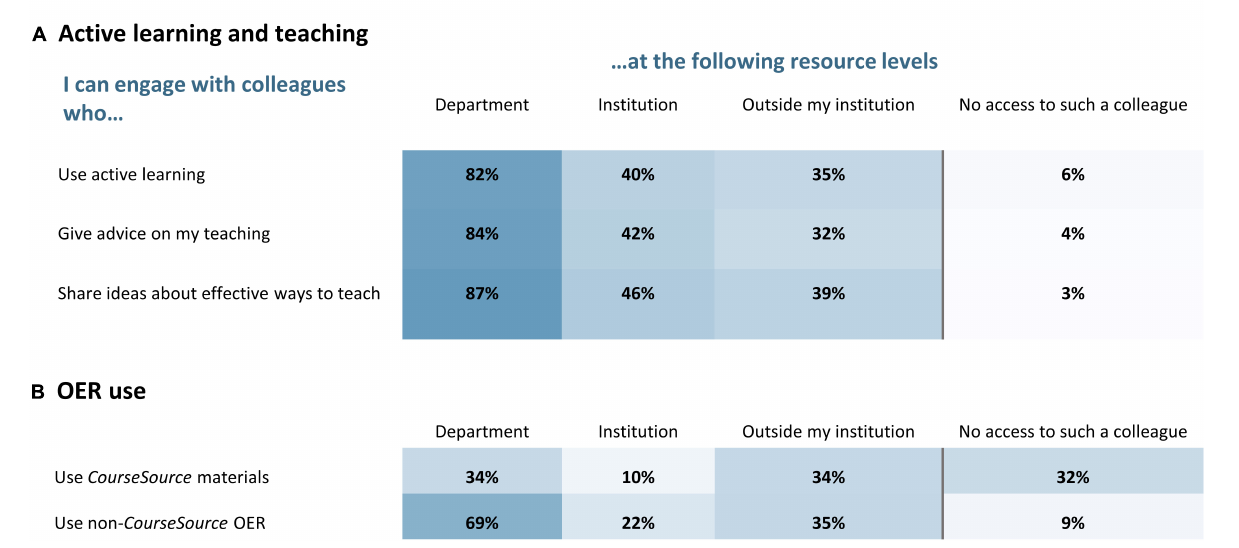
Frontiers in Education |